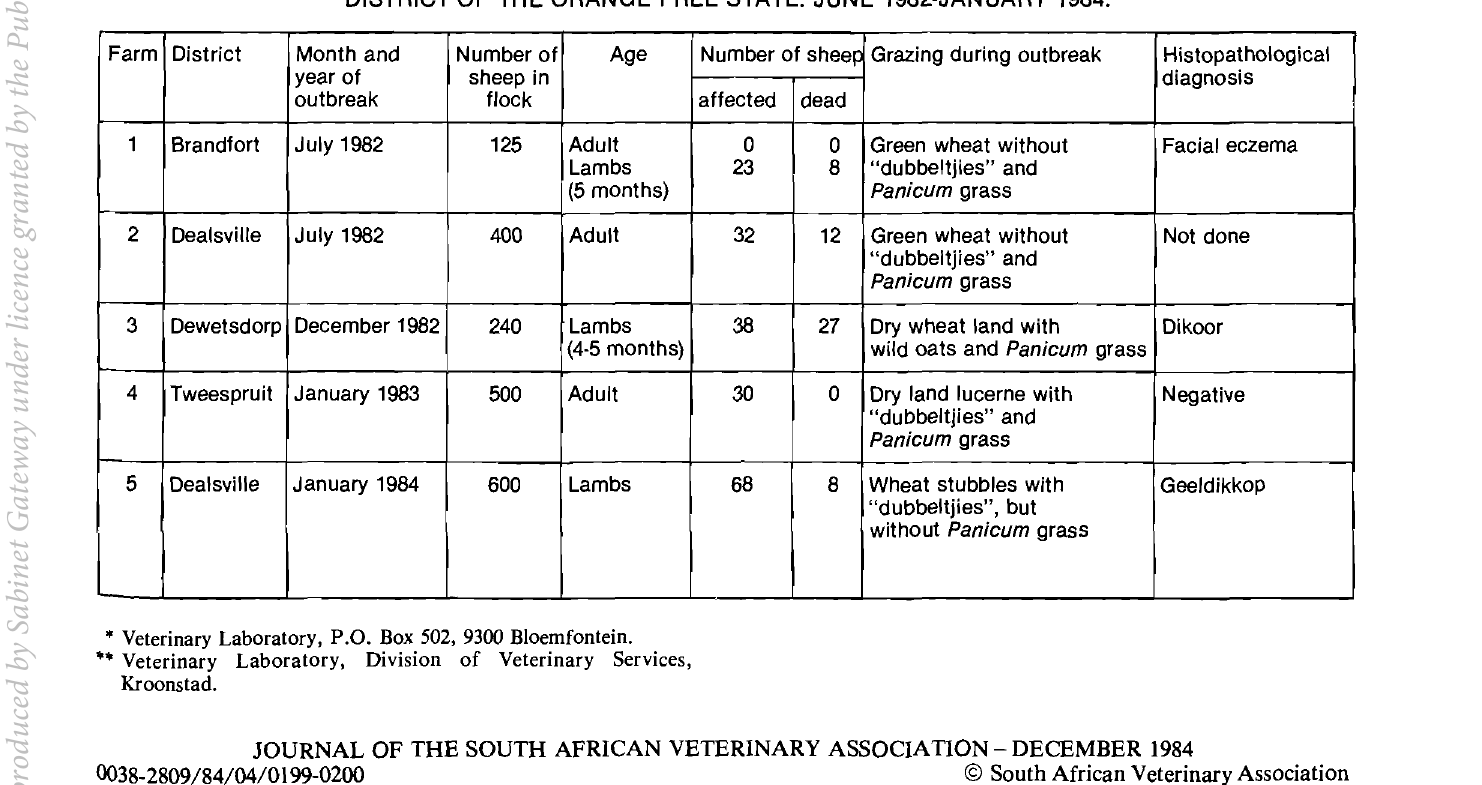
Table 1: DETAILS OF OUTBREAKS OF DIKOOR, GEELDIKKOP AND FACIAL ECZEMA IN SHEEP IN SOME CENTRAL DISTRICT OF THE ORANGE FREE STATE. JUNE 1982-JANUARY